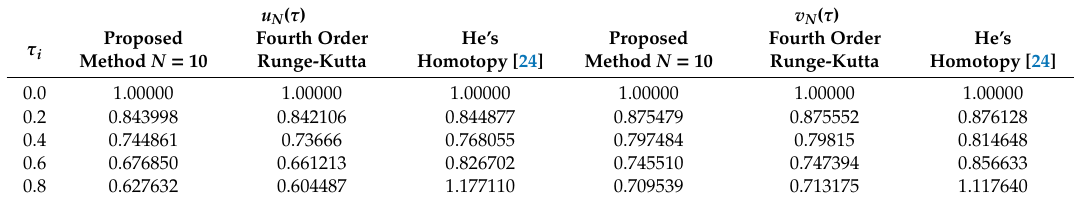
Table 7. Numerical results for v N ( τ ) and u N ( τ ) at N = 10 compared with another methods. Table 8 . The residual errors of the RC collocation method and He’s Homotopy.